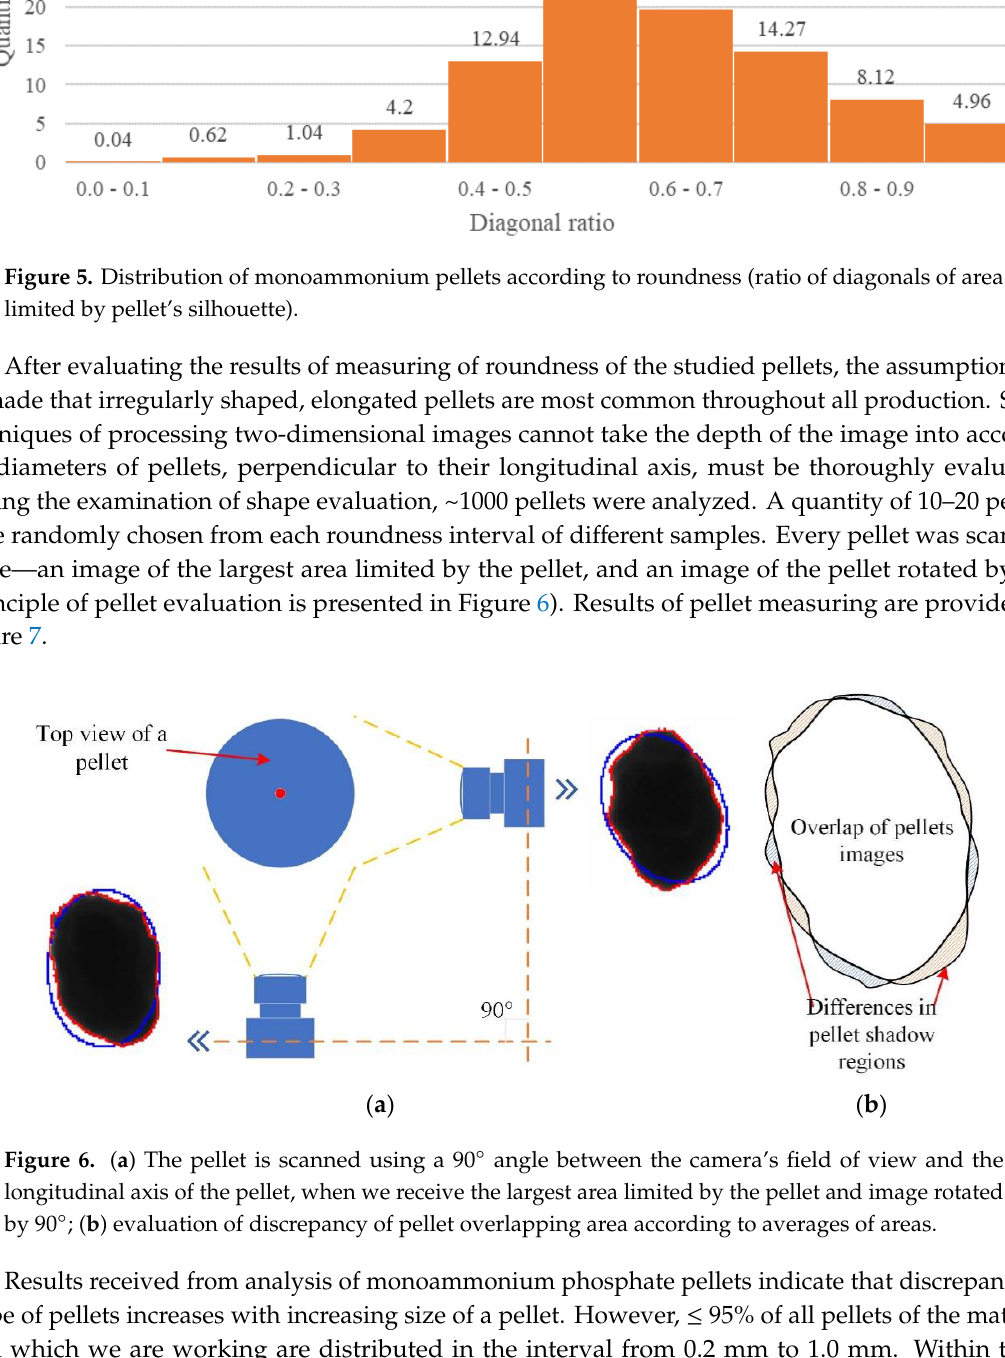
Figure 7. Average discrepancy of area limited by the pellet’s silhouette when pellets are evaluated according to their size and roundness. Results received from analysis of monoammonium phosphate pellets indicate that discrepancy of shape of pellets increases with increasing size of a pellet. However, ≤ 95% of all pellets of the material with which we are working are distributed in the interval from 0.2 mm to 1.0 mm. Within these boundaries, roundness of pellets according to ration of diagonals is distributed within